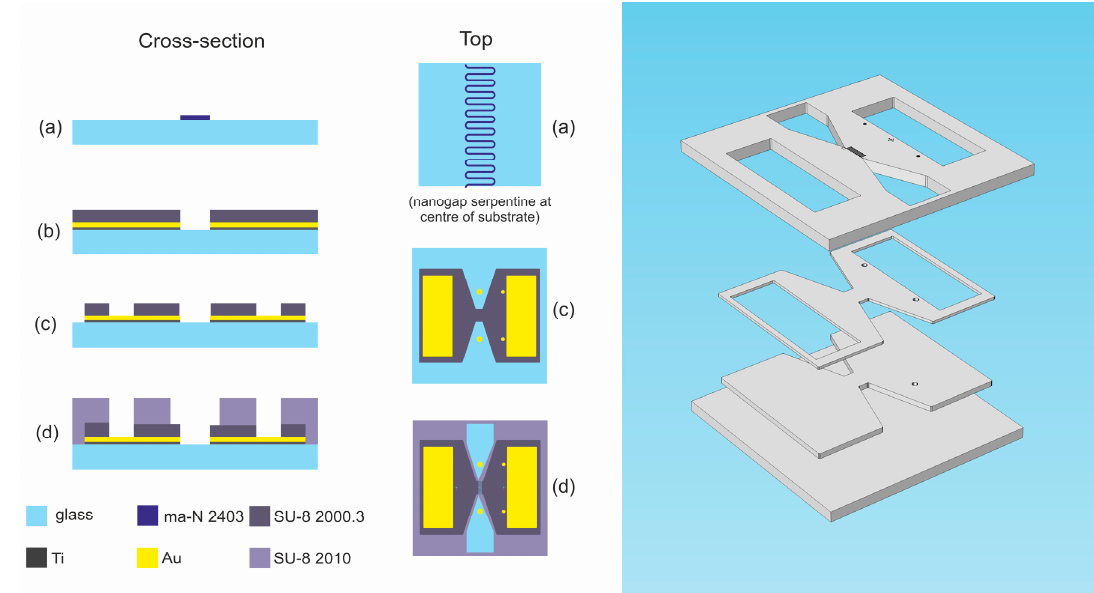
Figure 1. Left: Diagram showing the cross-section and top views of device after: ( a ) patterning of ma-N 2403 resist for electrode liftoff; ( b ) etching of SU-8 in nanogap; ( c ) etching to define device area and provide access to contact pads; and ( d ) patterning of microfluidic serpentine. Right: Exploded 3D diagram of device layers.